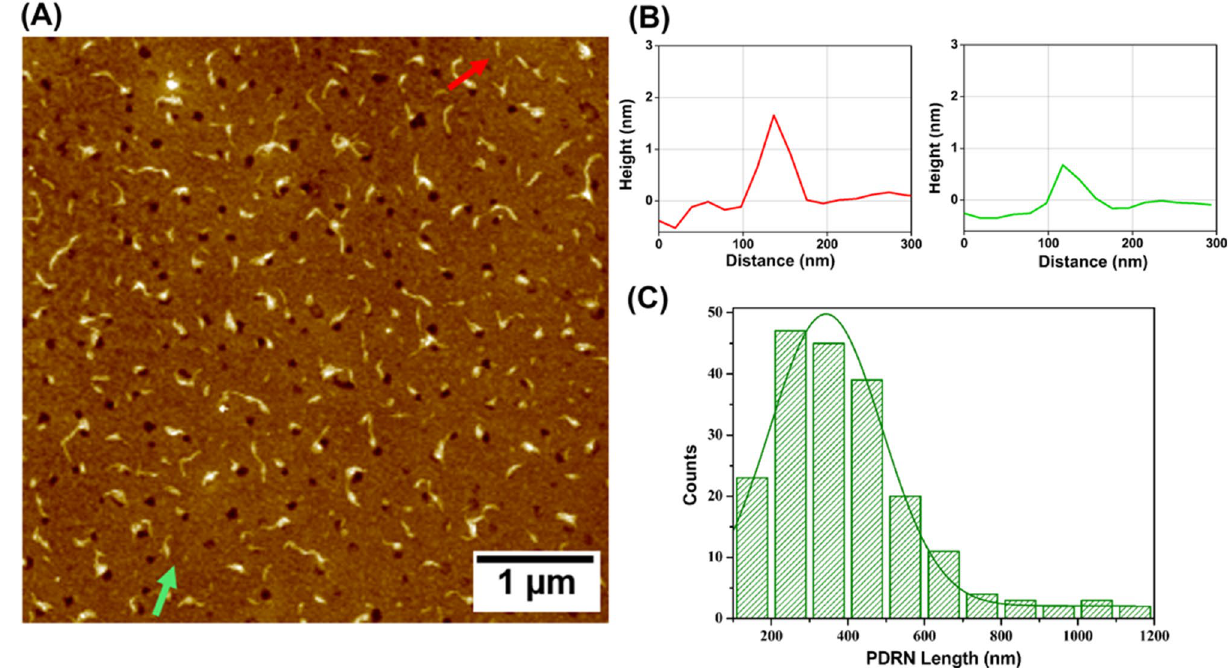
Figure 2. ( A ) AFM image showing PDRN morphology. ( B ) Line profile of the height of PDRN indicated by the red and green arrows in ( A ). ( C ) Length distribution of